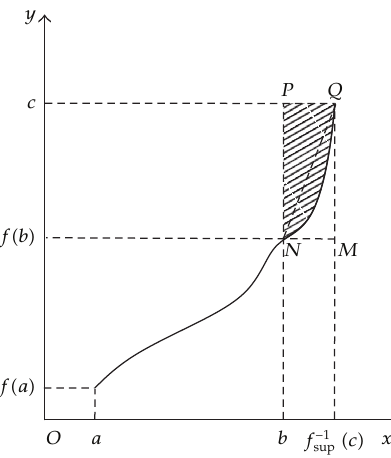
Figure 6: The geometry of the case c ≥ f (cid:5) b (cid:4)